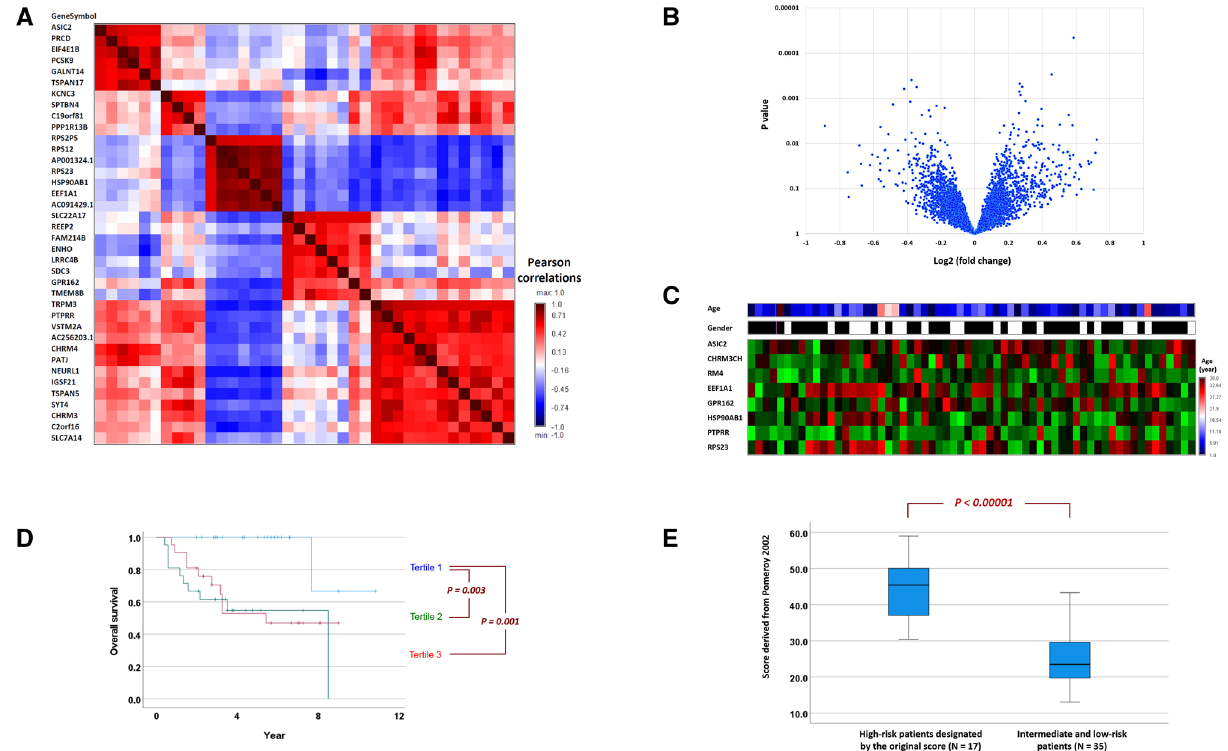
Figure 4. Transferability of gene signatures across datasets. ( A ) Pairwise correlations of a set of 38 genes which are highly correlated with one of the five leading genes, ASIC2, KCNC3, RPS2P5, SLC22A17 and TRPM3 (Pearson’s correlation > 0.65), and are referred to as the core-transferability gene set. Highly correlated genes are the surrogates of each other for the transfer of models across datasets. ( B ) The volcano plot of the transcriptome-wide comparisons of patients of the United States cohort who have or have not remained alive during the follow-up. ( C ) Age, gender and gene expressions of 8 genes of the United States cohort. All the 8 genes are within the core-transferability gene set. ( D ) Patient strata by the gene-signature score generated from the 8 genes manifest distinct overall survival. P values in the Kaplan–Meier plots were calculated by the log-rank test; ( E ) The high-risk stratum and average-risk stratum of the Taiwan cohort manifest distinct gene-signature score derived from the Pomeroy